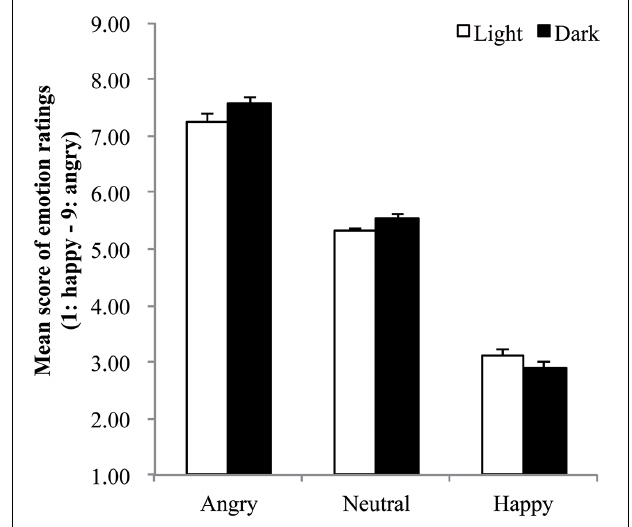
FIGURE 1 | Mean score of emotion ratings for each emotional expression as a function of the darkness. Black bars represent ratings for dark condition; white bars represent ratings for light condition. Error bars indicate standard